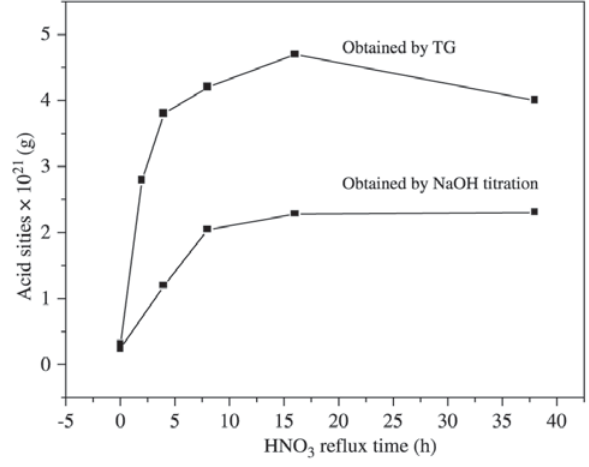
Figure 4. Acid sites concentration (as –COOH) on carbon surface for the different reflux time.